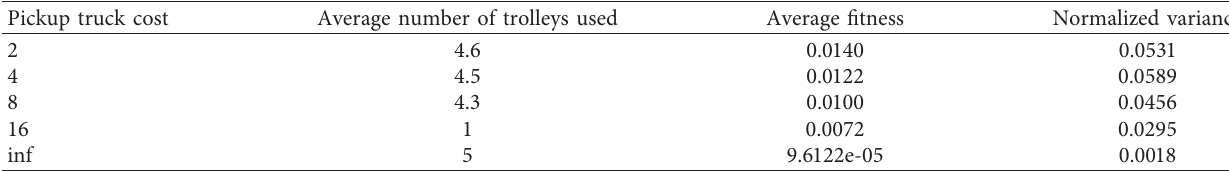
Table 5: Recommended quantity for pickup by